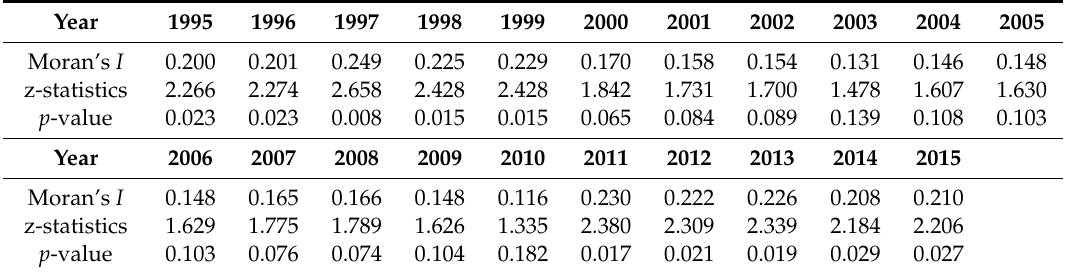
Table 2. Spatial autocorrelation of annual SO 2 emissions.